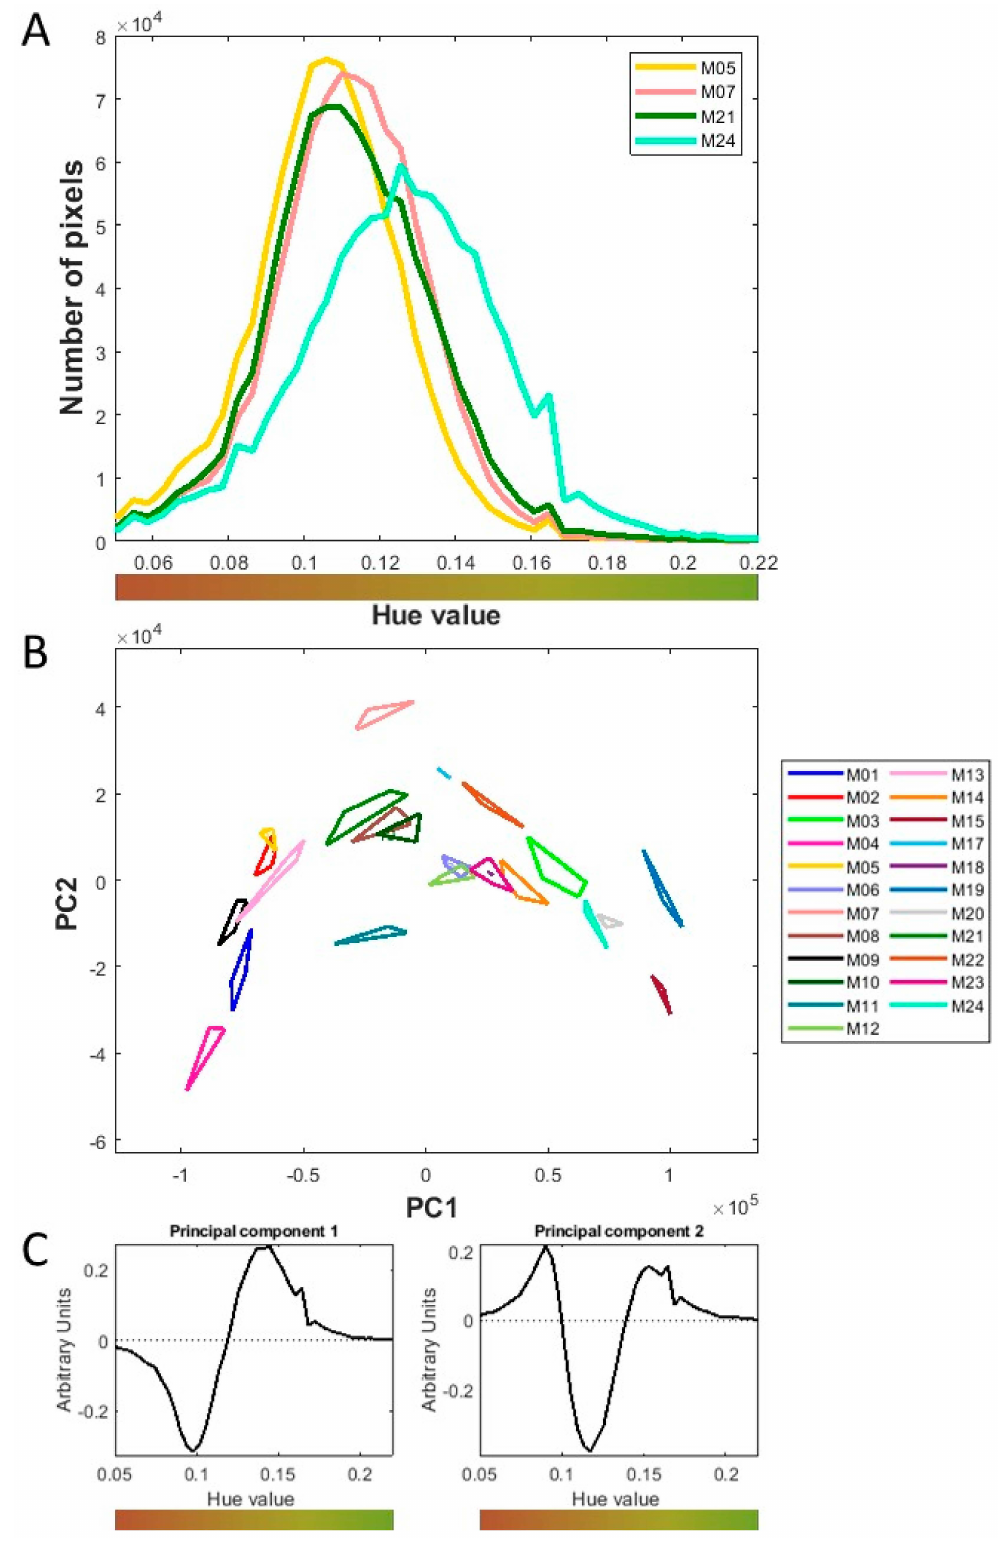
Figure 5. Color analysis of the 24 inbred lines of maize (chopped samples). ( A ) Hue histograms calculated from hue satura-tion volume images of four samples. ( B , C ) Principal component analysis based on hue histograms: similarity map ( B ) and loadings ( C ) of components 1 and 2 (89 and 8% of total variance, respectively). The bands below the hue value axes correspond to hue values between 0.05 and 0.22 to give a visual picture of the corresponding